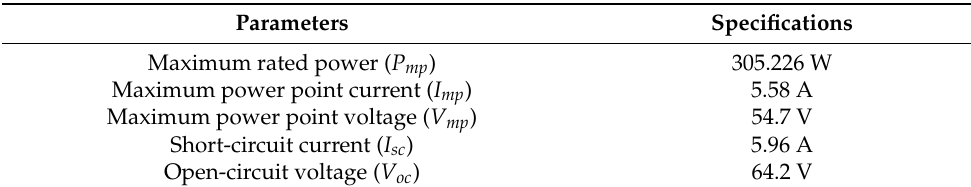
Table 1. SPR-305NE-WHT-D photovoltaic module specifications.